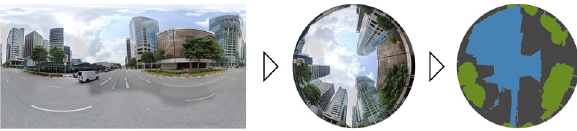
Figure 5. Example of original SVI panorama processed into a visual hemisphere for sky view factor calculation, together with the segmented result.